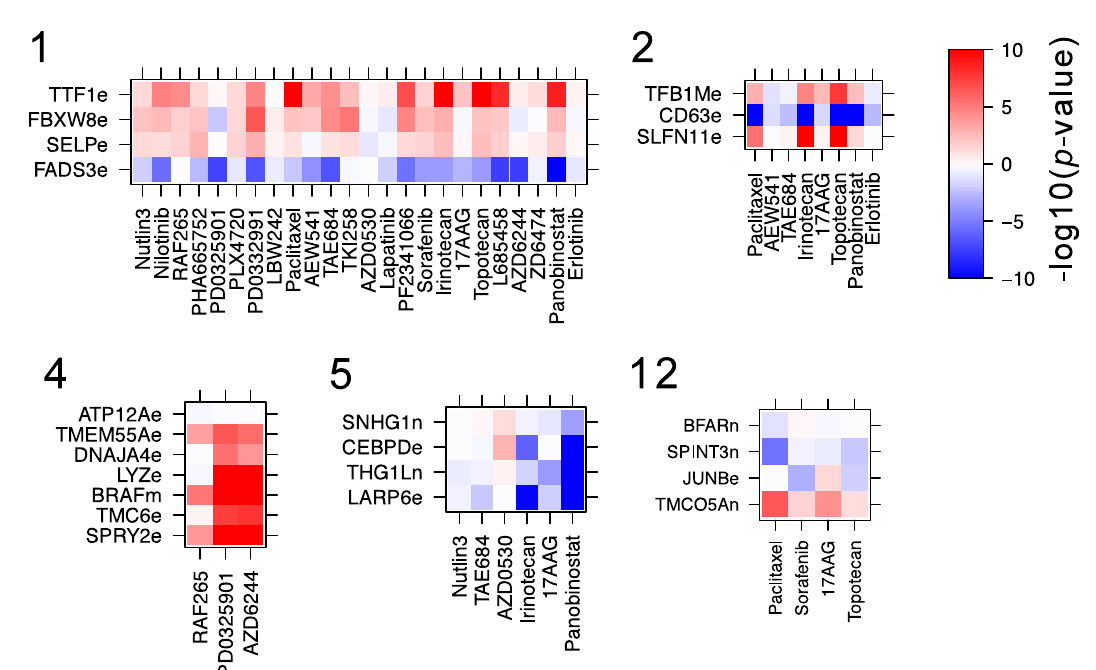
Fig 4. A subset of the learned latent characteristics represented as clusters of genomic features (rows) and drugs (columns). Numbering corresponds to the internal LC identifier and is arbitrary. Colors represent − log 10 p for the relationship between the feature and drug, with the sign representing positive or negative associations (using Spearman correlation). Genomic feature suffixes e = expression, n = copy number variation, m = mutation. The remaining LCs are shown in S8